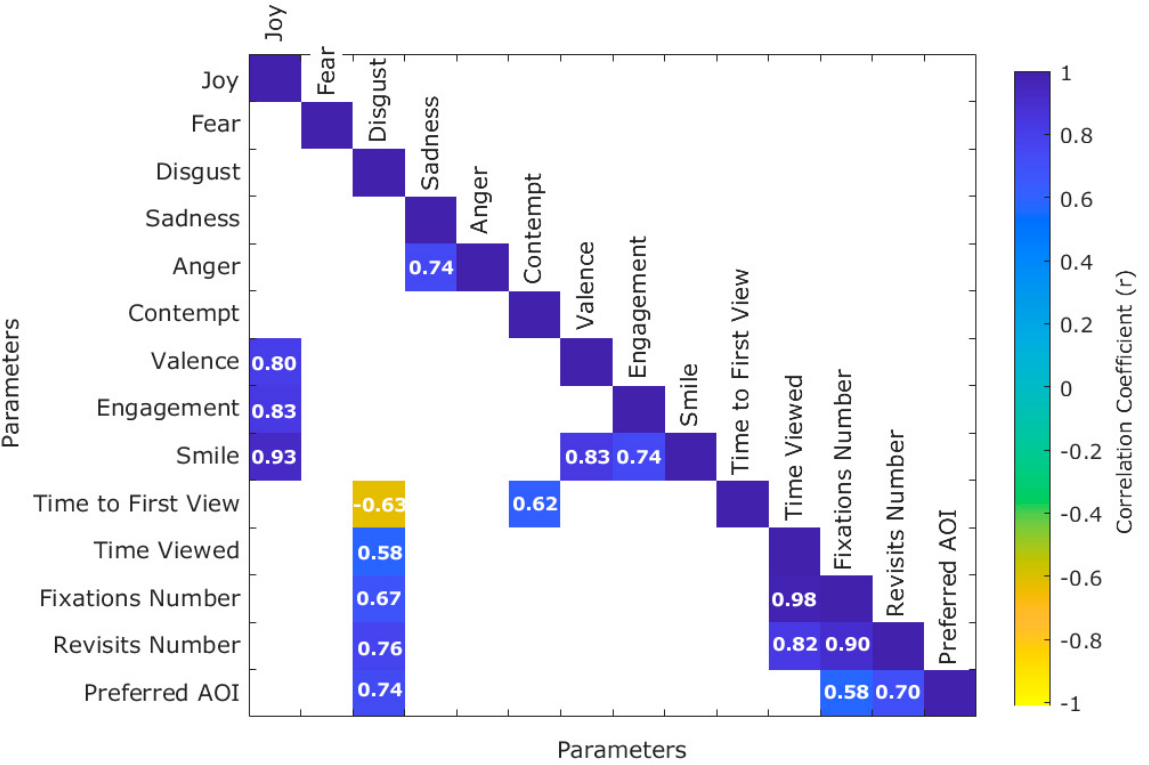
Figure 7. Matrix showing the significant correlations ( p < 0.05) between emotional responses and eye-tracking parameters. Color bar represents the positive (blue) and negative (yellow) correlations.